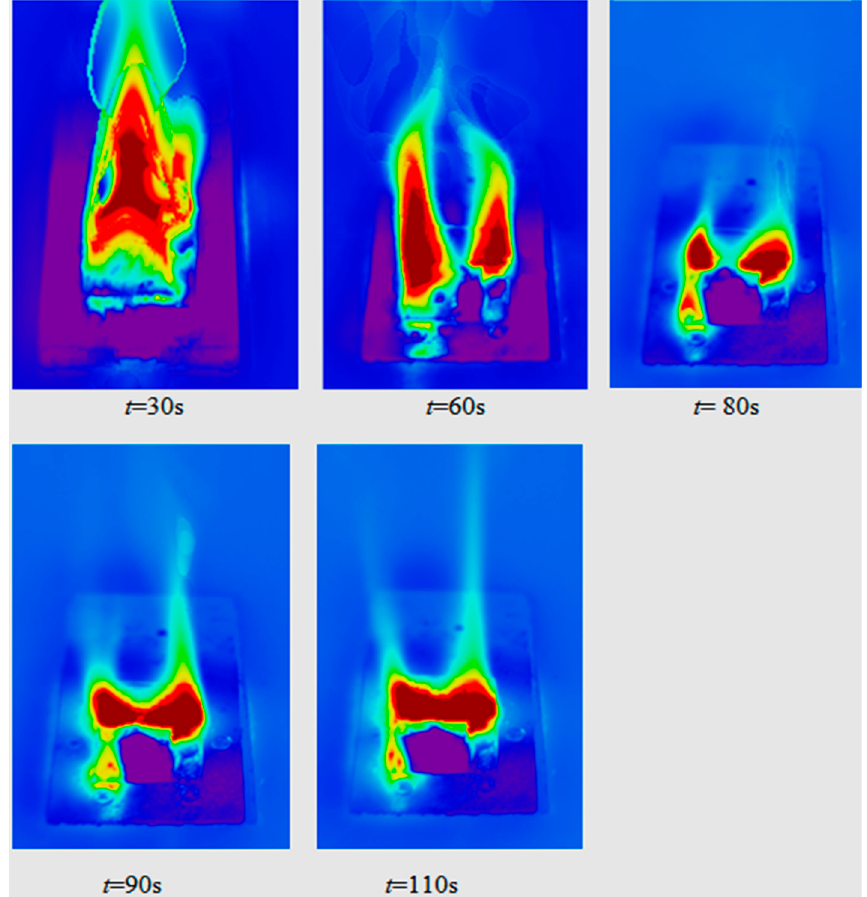
Figure 12. Thermal imaging photos of methane hydrate combustion ( U 0 = 0 m/s).